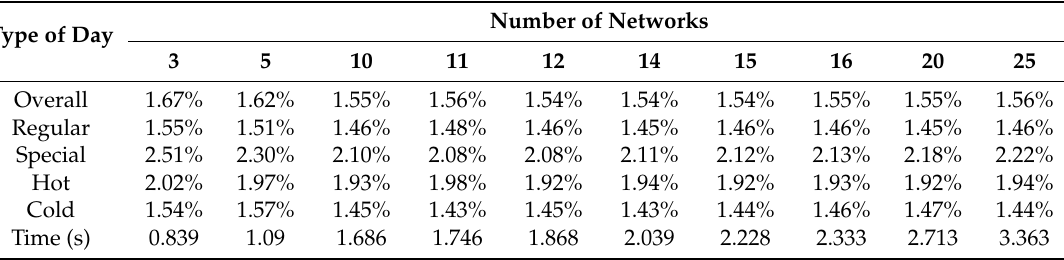
Table 6. Forecasting error (RMSE) and execution time with different redundant networks.